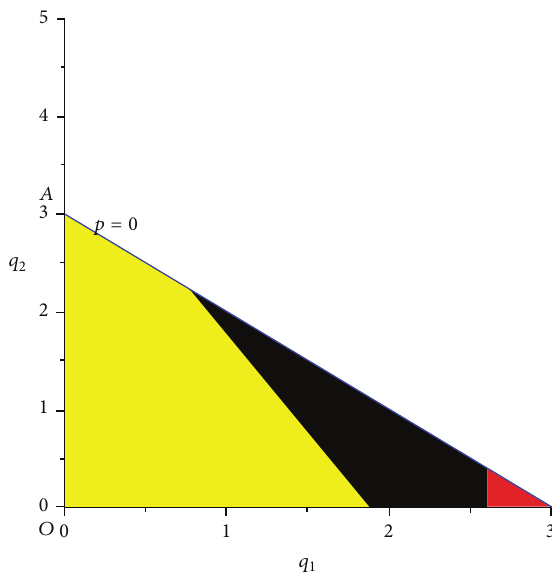
Figure 5: Different colours correspond to different behaviours of the model. In the yellow region, 𝑞 1 > 0 and 𝑞 2 > 0 . In the red region, = 0 and 𝑞 = 0 . In the black region, 𝑞 𝑞 1 2